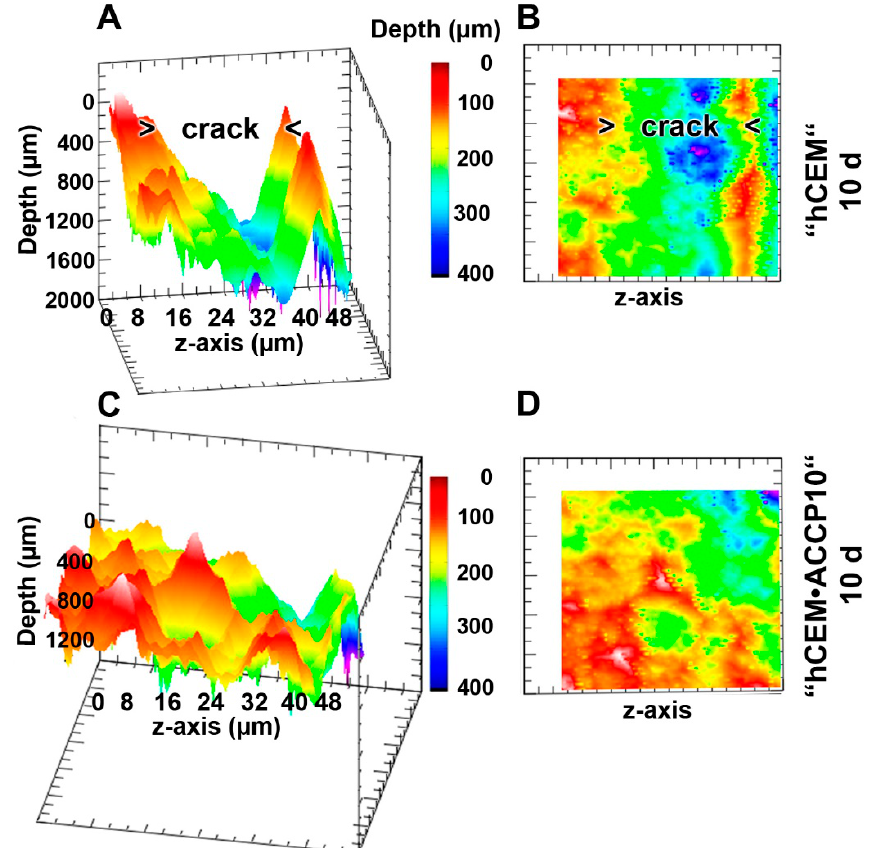
Figure 10. Surface texture image analysis of samples around the crack area taken from ( A , B [corresponding image to A ]) “hCEM” control cement specimens, aged for 10 days and post-incubated in water for additional 10 days and from ( C , D ) polyP-doped samples, “hCEM • ACCP10” (10 days plus 10 days); digital microscopic analysis using false color imaging. The crack regions in the control images ( A , B ) are marked ( > crack < ); in the “hCEM • ACCP10” samples no pronounced crack regions could be identified by light microscopy. Representative images are shown. The regions are analyzed both in y-axis and z-axis directions. Measurements are given in μ m.